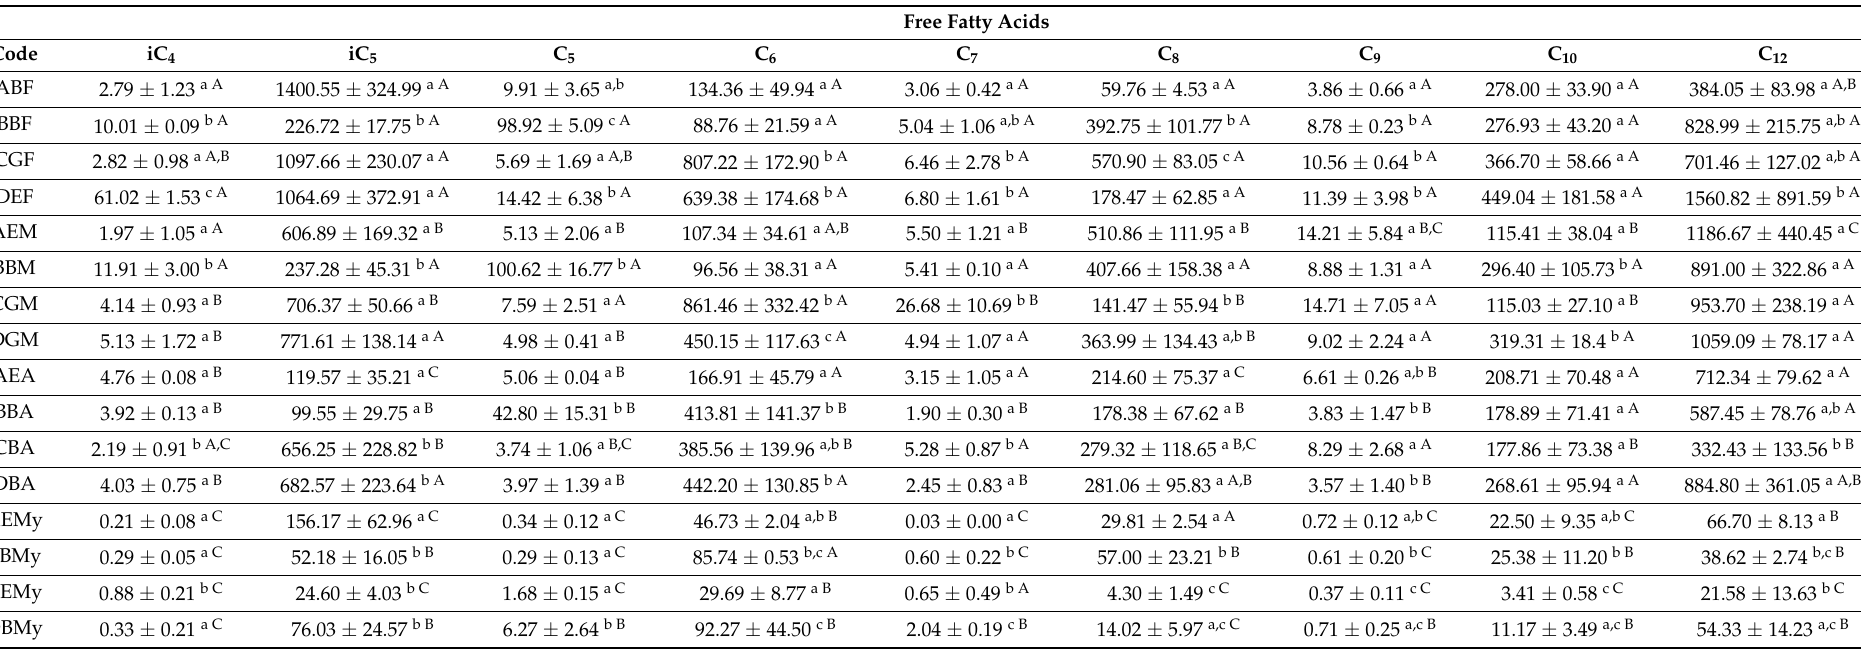
Table 5. Volatile free fatty acids (mean ± standard deviation; mg/100 g) in samples from producers A, B, C and D, during four consecutive months of